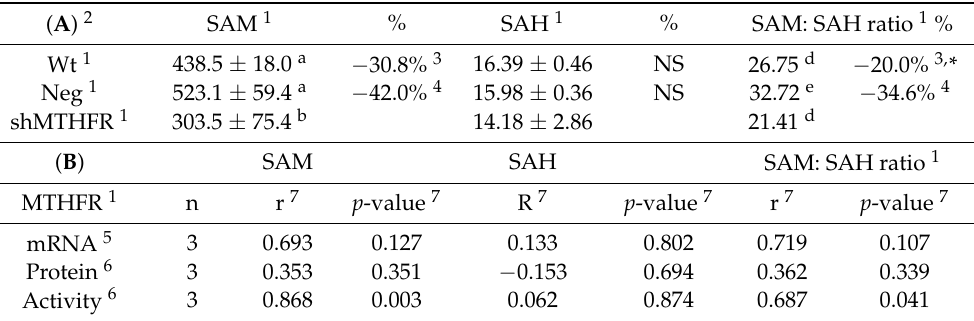
Table 2. MTHFR knockdown alters intracellular SAM and SAH contents in HepG2 cells. (A) MTHFR knockdown significantly decreased intracellular SAM contents and SAM to SAH ratio; (B) the associations between MTHFR mRNA, protein, enzyme activity and SAM, SAH, Hcy and cysteine concentrations in HepG2